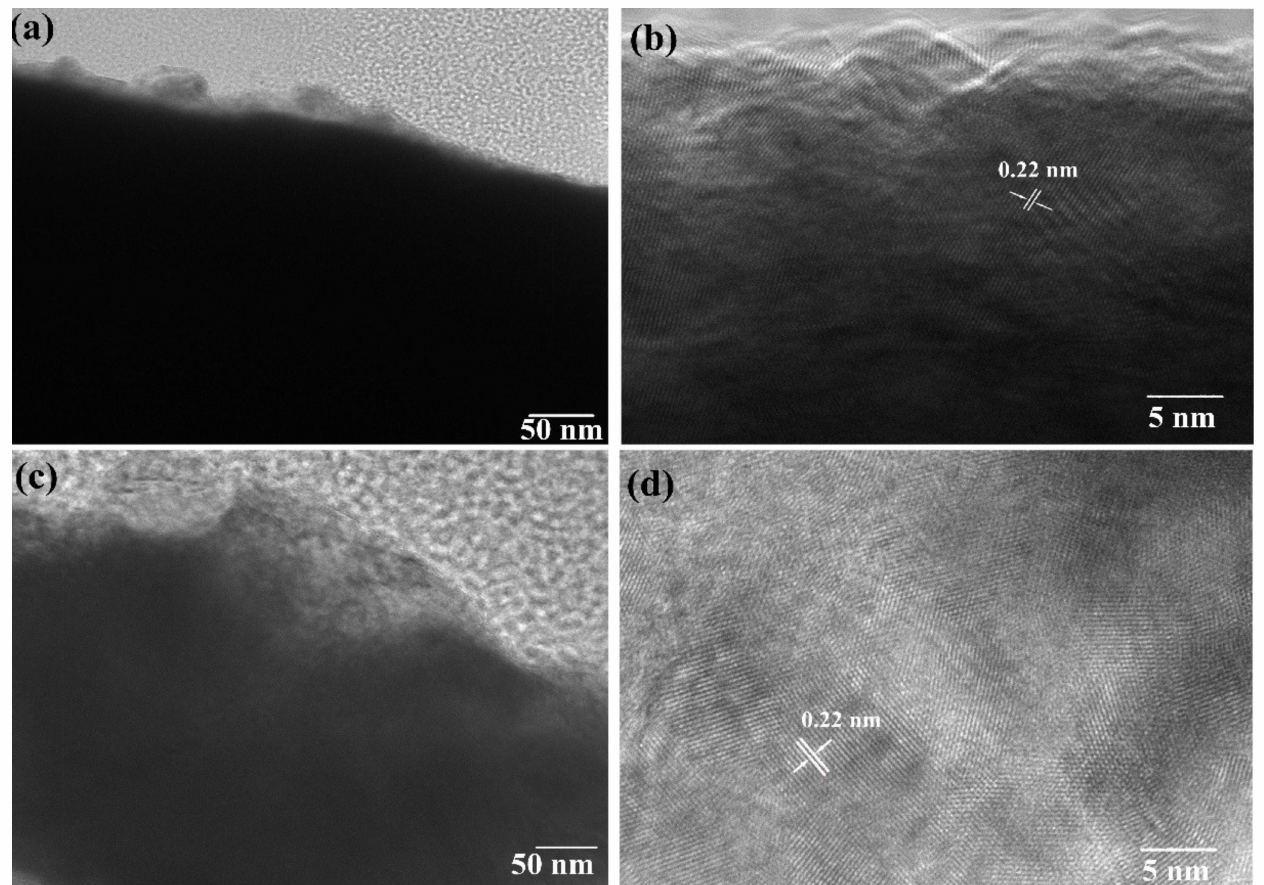
Figure 6. TEM analysis of copper foam. ( a ) TEM image of copper foam (no reaction, 80,000 × ), ( b ) TEM analysis of lattice spacing of copper foam (no reaction, 800,000 × ), ( c ) TEM image of copper foam (after one reaction, 80,000 × ), and ( d ) TEM analysis of lattice spacing of copper foam (after one reaction, 800,000 ×